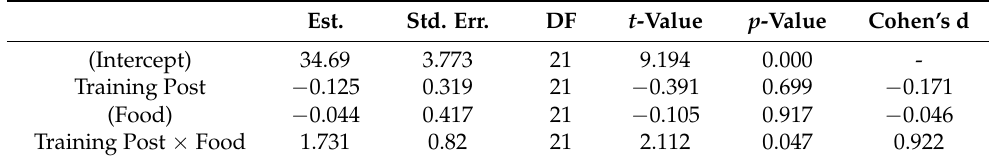
(Est.) correspond to one-repetition maxima [kg] and respective changes. Table 4. Coefficients of the linear mixed effects model (LME) fitted to the chest press data. Estimates